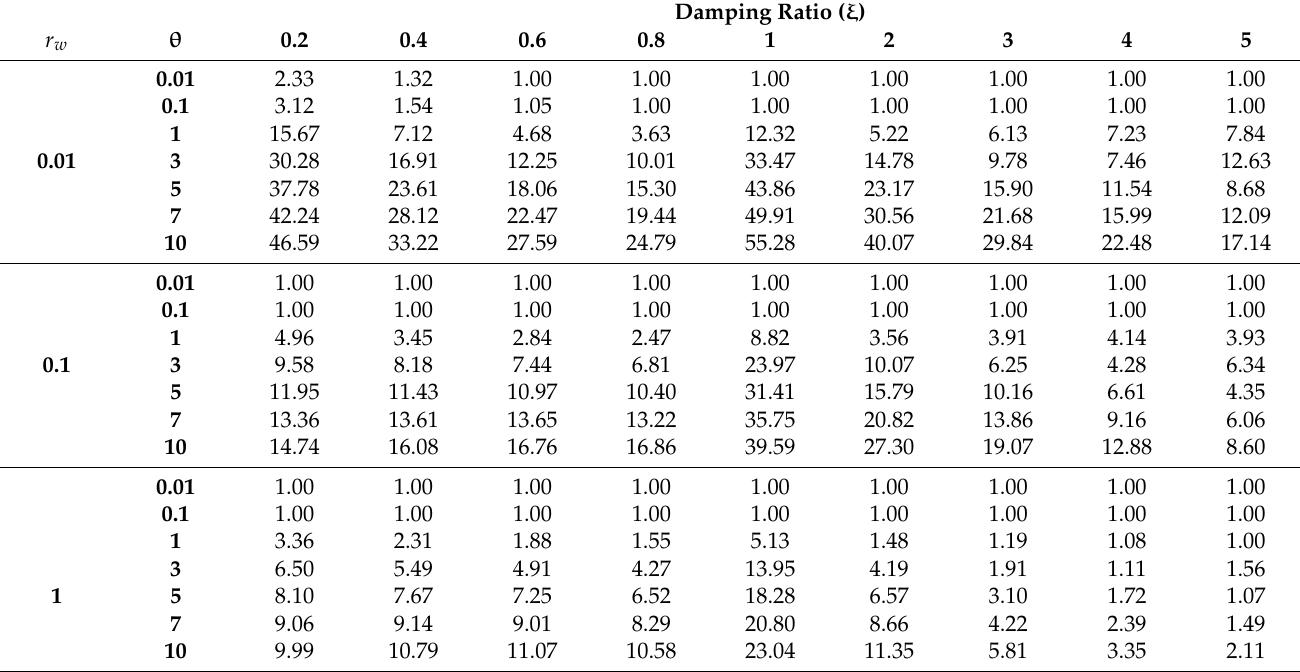
Table 13. Normalized TV for MPC (Process 4, Setpoint